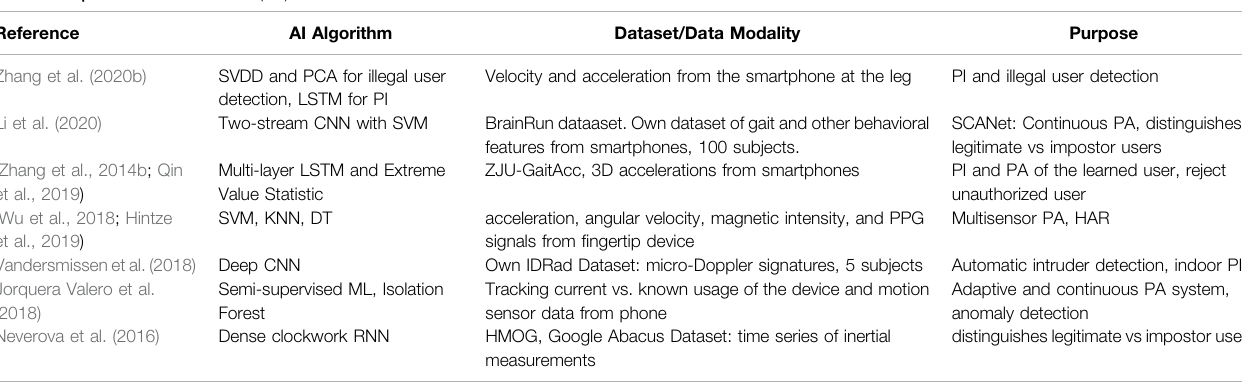
TABLE 10 | Person authentication